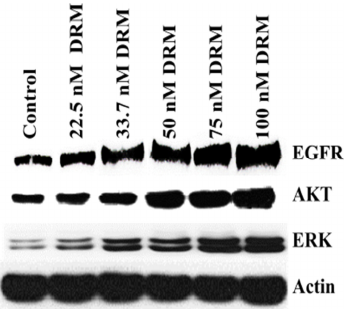
Figure 8. DRM cells showed high EGFR activity. Western blot analysis of EGFR and the downstream signal, Akt and ERK. Cells were seeded with a seeding density of 5 × 10 4 cells and grown for 72 h. The control cells were left untreated. The whole-cell protein lysate was prepared, and 30 μg of pro- teins were resolved in SDS-polyacrylamide gels. Western blots were confirmed by three independ- ent experiments. DRM: Doxorubicin-resistant MDA-MB-231. 2.7. Doxorubicin Resistance of DRM Cells Can Be Transferred to p-MDA-MB 231 Cells by Autocrine Signaling Cell to cell communication networks have been one of the many driving forces behind the development of drug resistance and CSC [28,37]. Thus, to determine whether autocrine mechanisms are implicated in the tumor microenvironment, we grew the parental cells in the resistant cell-grown media and compared them against cells grown in fresh cell media. The parental cells grown in resistant cell media showed an almost similar pattern of DRM cells in terms of the expression of CSC and EMT phenotype (Figure 9). These results show